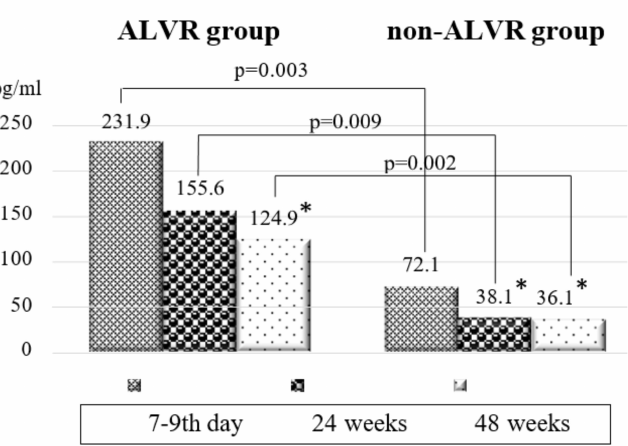
Figure 3. Dynamics of BNP in the comparison groups. Note: * p < 0.05 are significant differences between the initial values and subsequent visits. BNP –brain natriuretic